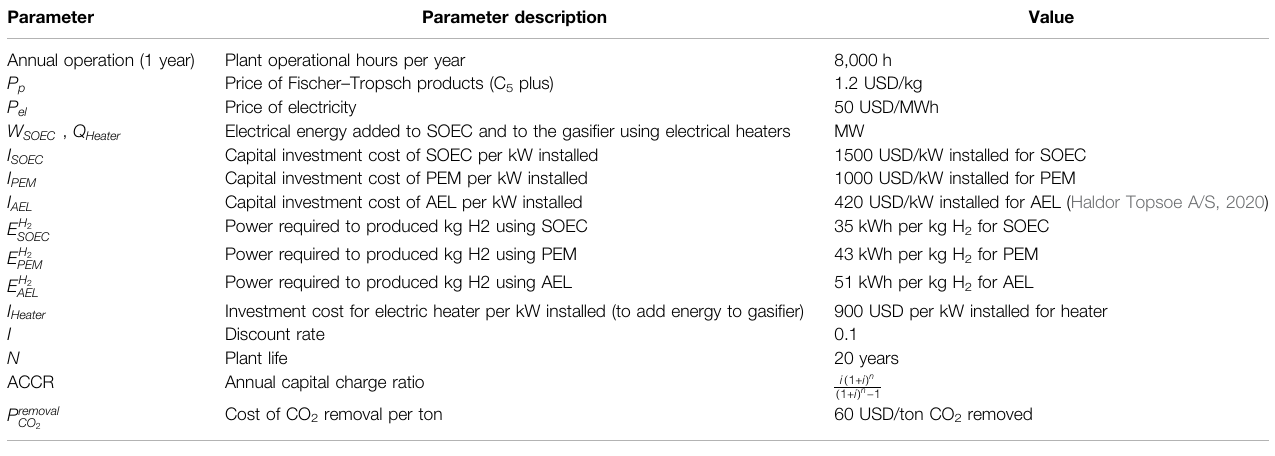
TABLE 4 | Parameter values used in calculation of criterion.